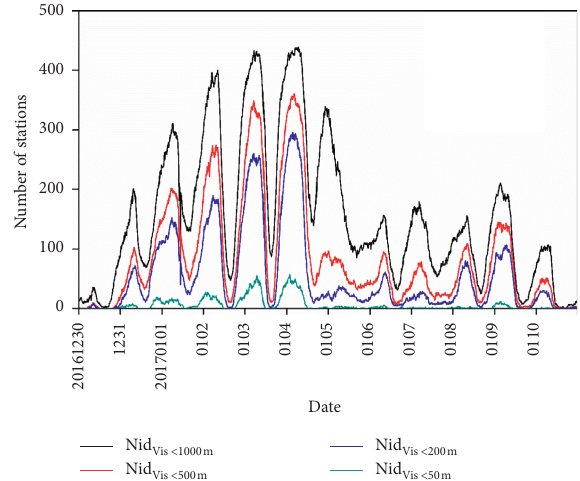
Figure 3: The number of stations that have observed the fog, DF, SDF, and EDF in the study area from December 30, 2016, to January 10, 2017.